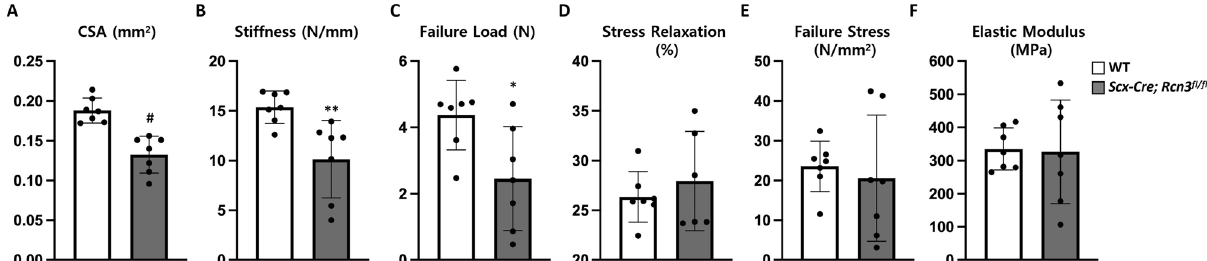
Figure 6. Mechanical property, cross-sectional area ( A ), stiffness ( B ), failure load ( C ), stress relaxation ( D ), failure stress ( E ), and elastic modulus ( F ) of Achilles tendons from wild-type mice and Scx-Cre; Rcn3 fl/fl (tendon-specific Rcn3 loss-of-function model) littermates at P60. (* indicates P < 0.05, ** indicates P < 0.01, and # indicates P < 0.001 between genotypes, n =